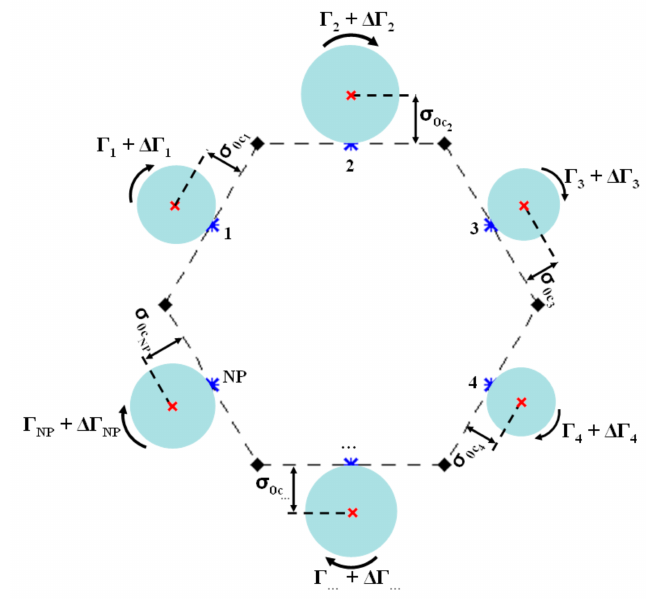
Figure 5. The boundary layer model to simulate a rough